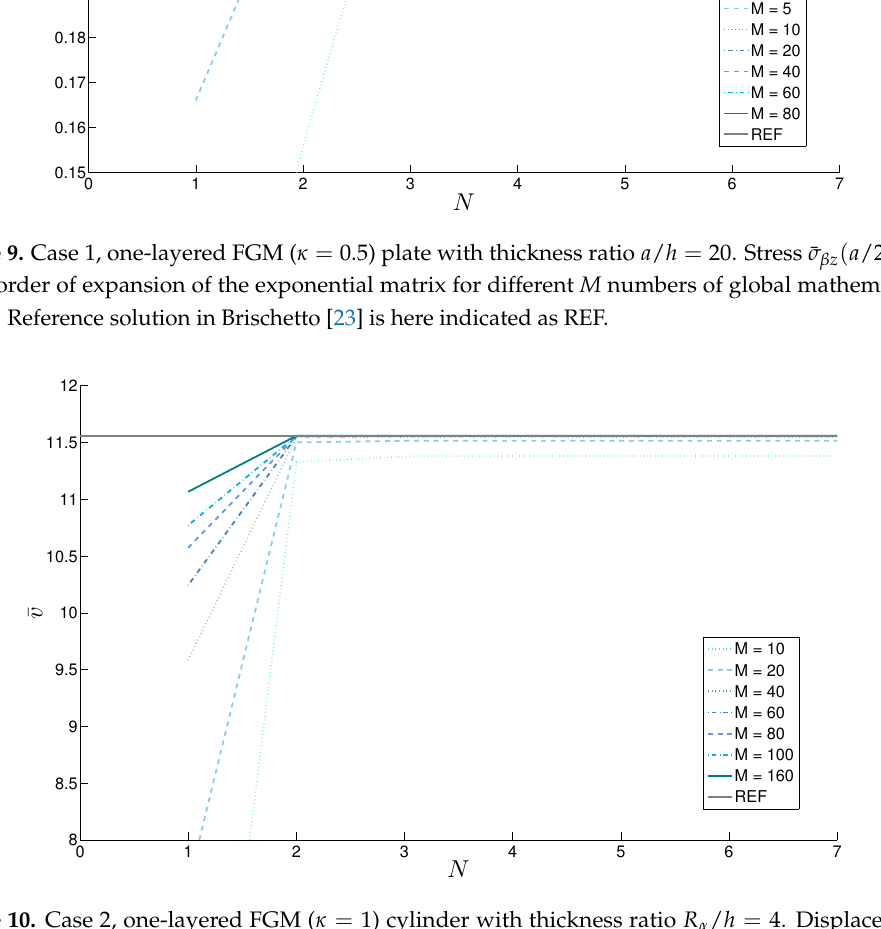
Figure 10. Case 2, one-layered FGM ( κ = 1) cylinder with thickness ratio R α / h = 4. Displacement ¯ v ( a /2,0,0 ) vs. N order of expansion of the exponential matrix for different M numbers of global mathematical layers. Reference solution in Brischetto [23] is here indicated as